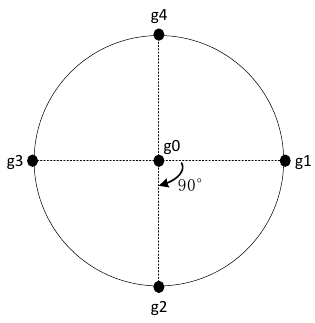
Figure 4. Schematic diagram of the sensor array plane.